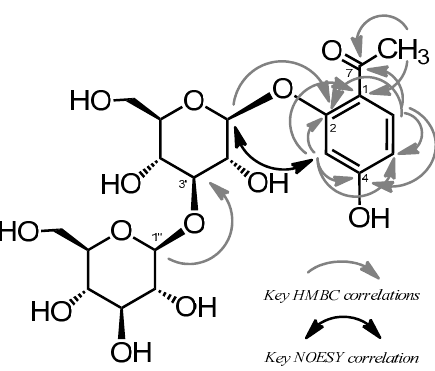
Figure 2. Key heteronuclear multiple bond connectivity (HMBC) correlations and nuclear Overhause effect spectroscopy (NOESY) correlation of compound 1 .